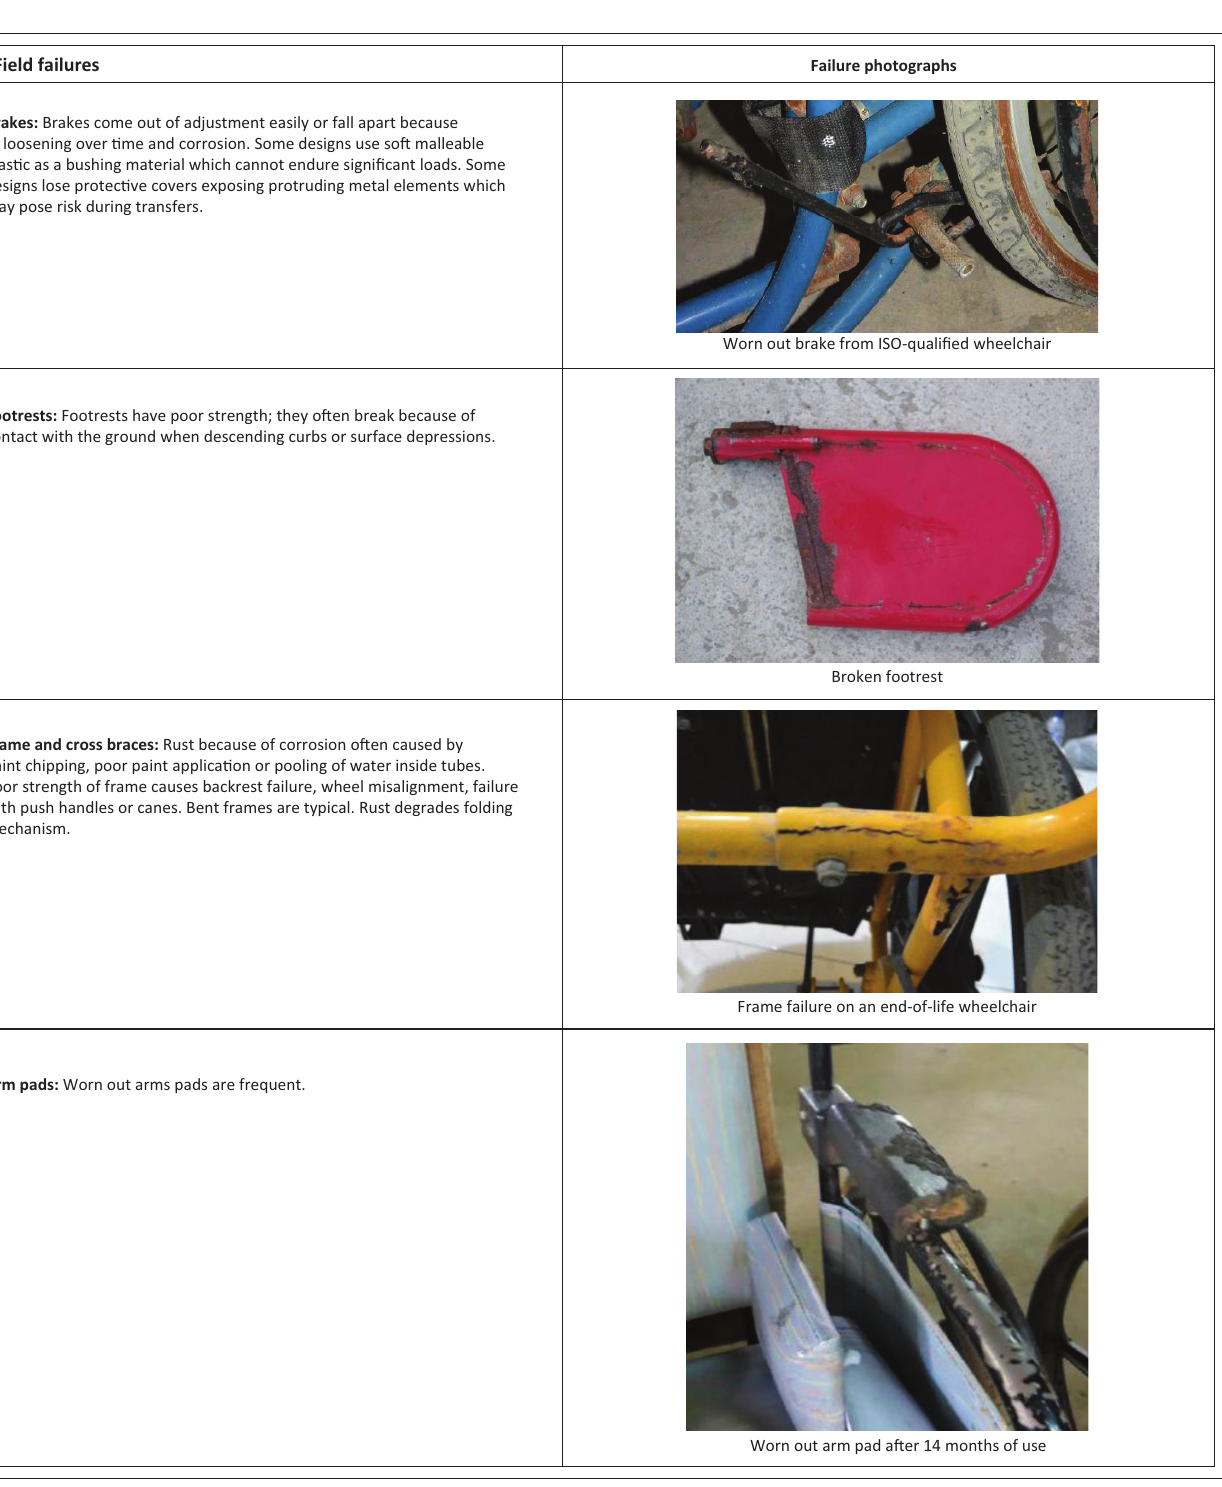
FIGURE 6 (Continues...): Failures noted by International Society of Wheelchair Professionals Standards Working Group experts on wheelchairs designed for less-resourced environment